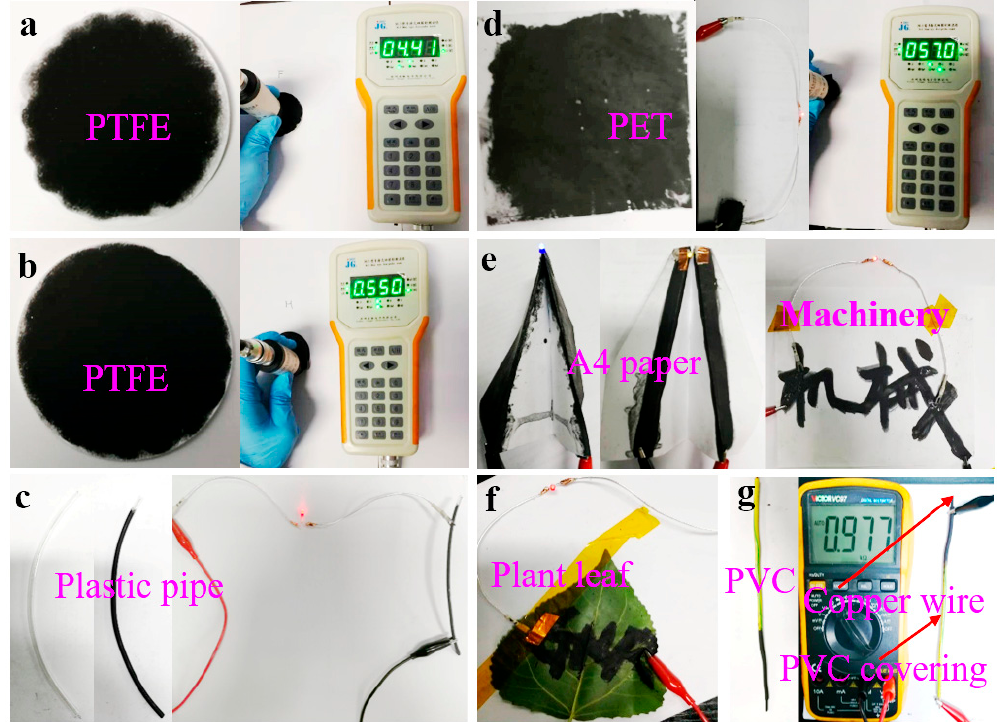
Figure 8. Photos of powders on various substrates: ( a ) PTFE filtered with the BFPs; ( b ) PTFE filtered with the FLG nanosheets; ( c ) conductive trace of the FLG nanosheets brushed on plastic pipe; ( d ) the FLG nanosheets filmed on PET by spin coating; ( e , f ) the FLG nanosheets filmed on A4 paper and plant leaves by brush coating; ( g ) conductive trace of the FLG nanosheets brushed on copper wire .